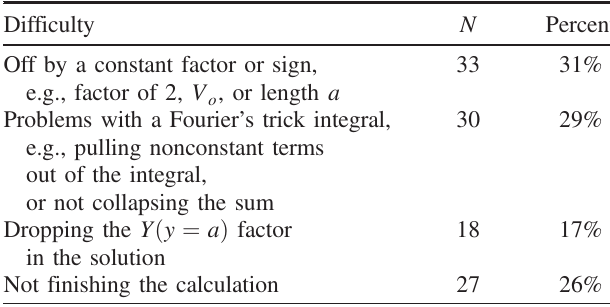
TABLE II. Common difficulties when executing the procedural mathematics of solving for constants in the general